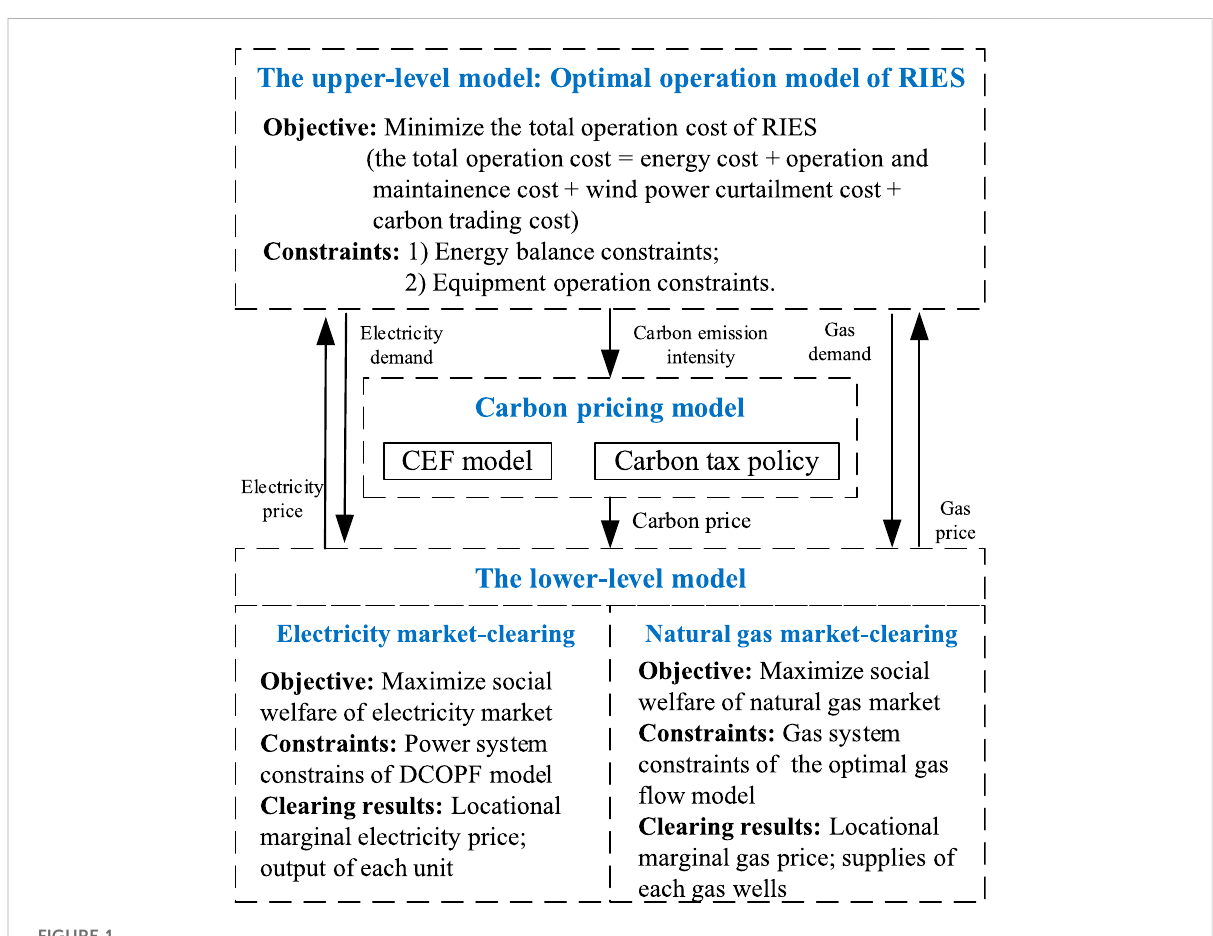
FIGURE 1 Framework of the optimal low-carbon operation model of